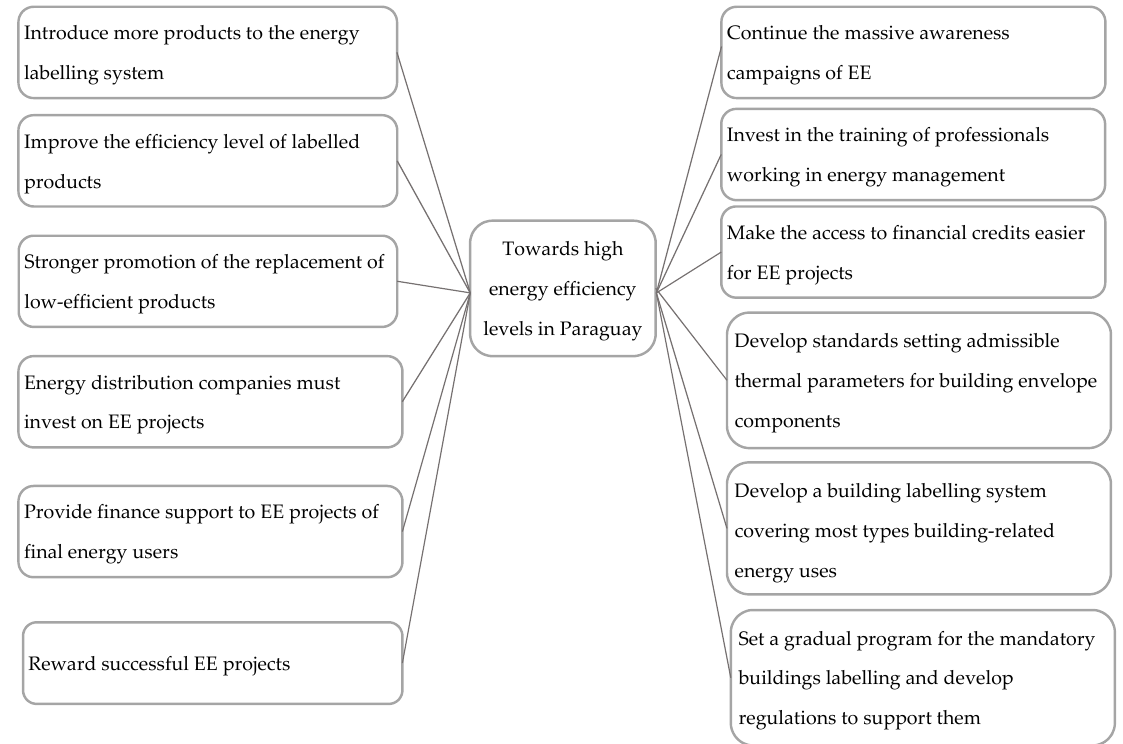
Figure 8. Energy e ffi ciency actions recommended for policymakers of Paraguay Figure 8. Energy efficiency actions recommended for policymakers of Paraguay [66].